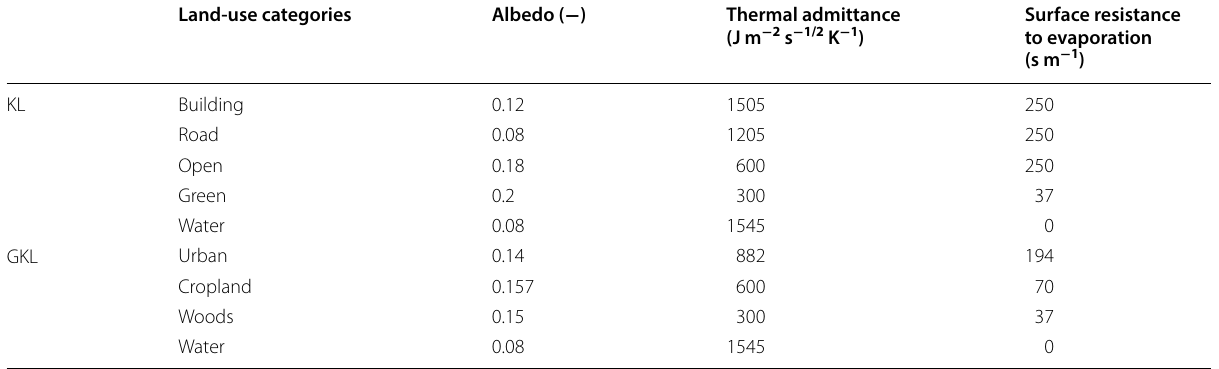
Table 1 Land-use categories and defined physical properties for Kuala Lumpur (KL) and Greater Kuala Lumpur (GKL) Land‑use